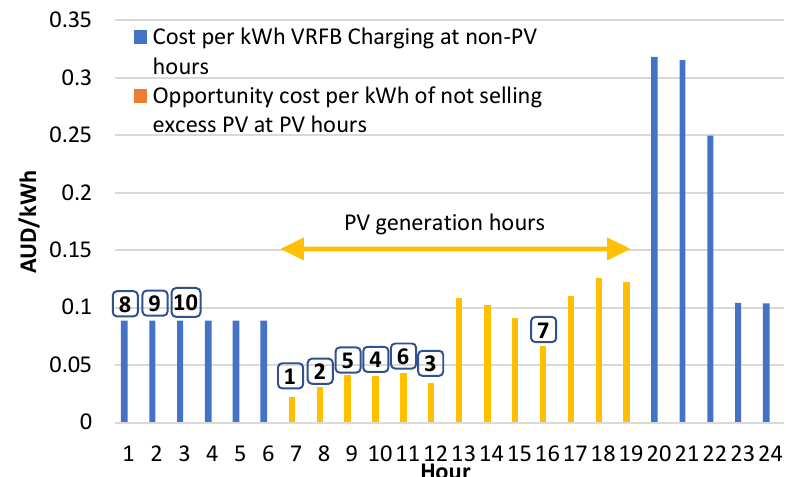
Figure 7. The charging hour priority for the vanadium redox flow batteries (VRFB) for a sample day.